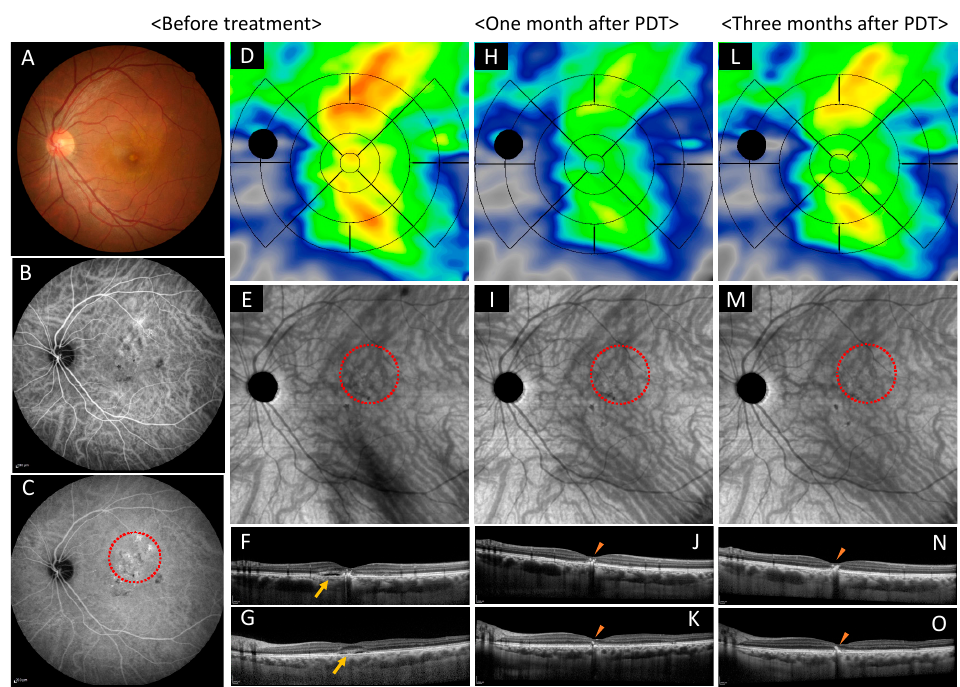
Figure 5. Images of the left eye of a 46-year-old male with chronic central serous chorioretinopathy. ( A – G ) Show before treatment, ( H – K ) show one month after the photodynamic therapy (PDT), and ( L – O ) show three months after the PDT. ( A ) Color fundus photograph shows the subretinal detachment and the retinal pigment epithelium abnormality at the macular area. ( B , C ) Early and late phase of indocyanine green angiography show dilated choroidal vessels, punctate hyperfluorescent spots, and choroidal vascular hyperpermeability. PDT irradiated the area highlighted with red dot circle. ( D ) Choroidal volume color map shows thickened choroid at superior, macular, and inferior areas before treatment. ( H ) Choroidal volume decreased at the superior, macular, and inferior areas after one month. ( L ) Three months after treatment, choroidal volume thickened again at the superior and inferior areas. ( E ) En face optical coherence tomography images show dilated choroidal vessels and lost watershed zone accompanied by superior and inferior choroidal vessel anastomosis before treatment. ( I ) Constriction of choroidal blood vessels was observed one month after treatment. ( M ) Three months after treatment, constriction of choroidal blood vessels was still observed. ( F , J , N ) are vertical scans and ( G , K , O) are horizontal sans through central fovea. ( F , G ) show shallow subretinal detachment before treatment (show arrow). ( J , K ) Serous retinal detachment resolved completely at one month after treatment, however intraretinal hyperreflective materials remained (show arrowhead). ( N , O ) No recurrence three months after treatment. Intraretinal hyperreflective materials remained (see arrowheads).